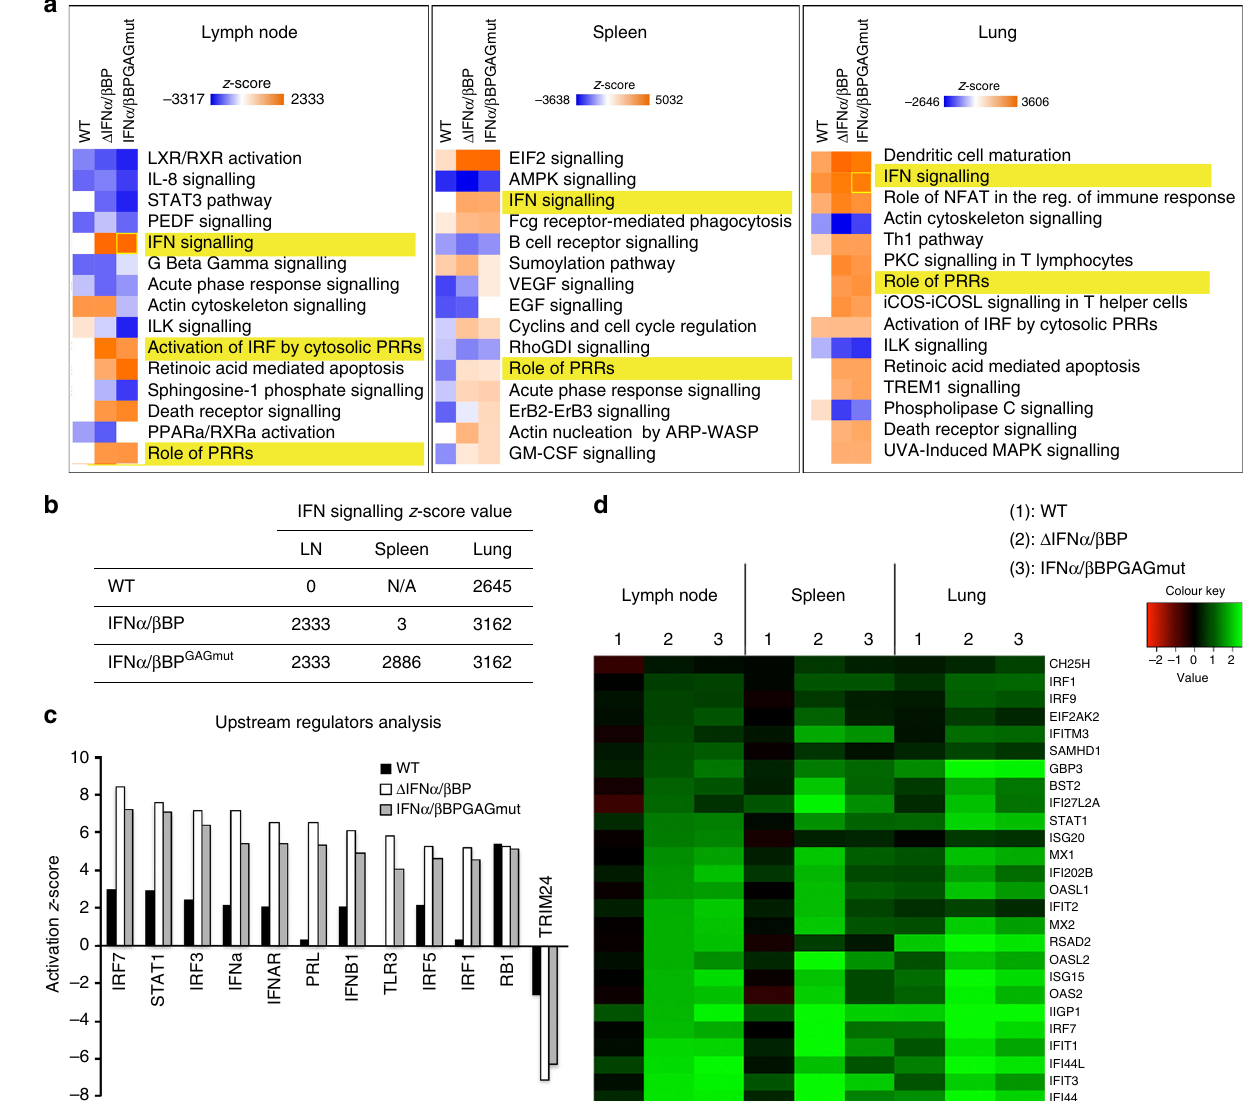
Fig. 9 RNA-seq analysis of the IFN response after infection with VACV IFN α / β BP mutants. Two groups of fi ve Balb/c mice per condition were i.n. inoculated with 10 3 pfu of the indicated VACV. Differential expression analyses against mock-infected samples were performed using biological duplicates. a Heatmap showing the activation z -scores for 15 signi fi cantly enriched pathways using the SDEGs retrieved after comparison of each VACV infected sample with the mock-infected samples. b Activation z -scores determined for the Interferon Signalling pathway and corresponding to each VACV infected sample after comparison to mock infection. c SDEGs were analysed by the IPA upstream regulator function (direct only) and the activation z -score values for the selected upstream regulators determined for VACV-WT (black bars), VACV Δ IFN α / β BP (white bars) and VACVIFN α / β BP GAGmut (grey bars) infections are shown. d Heatmap showing the expression values (log2FC) of the selected ISGs in the indicated VACV infected tissues